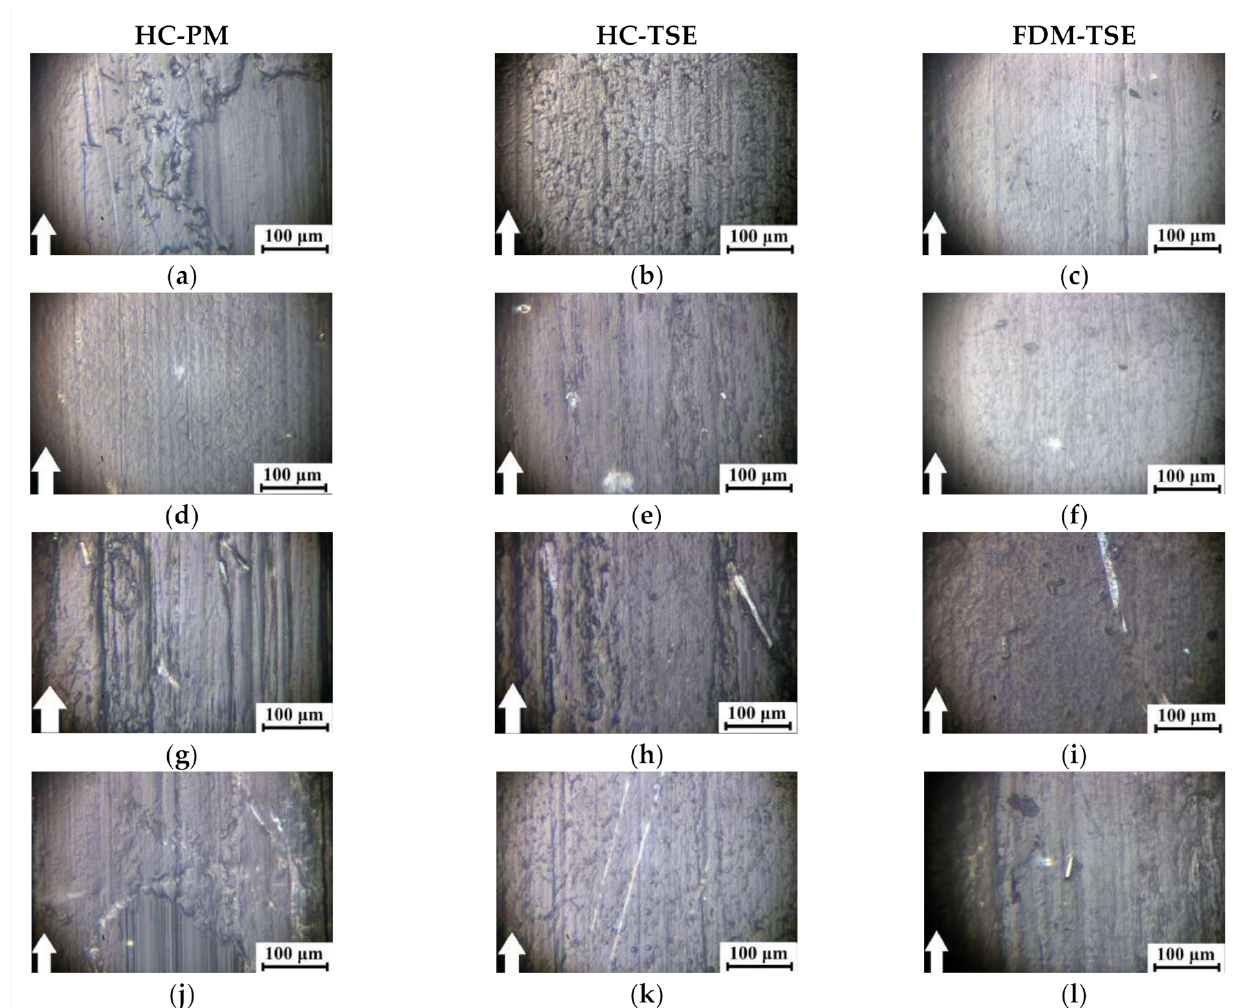
Figure 11. The wear track surfaces on the ‘UHMWPE+17%HDPE-g-VTMS+12%PP’ sample ( a – c ) and the composites ( d – l ) fabricated by the HC-PM, HC-TSE, and FDM-TSE methods: ‘UHMWPE+17%HDPE-g-VTMS+12%PP+5%HGS’ ( d – f ); ‘UHMWPE+17%HDPE-g-VTMS+12%PP+5%MGF’ ( g – i ); ‘UHMWPE+17%HDPE-g-VTMS+12%PP+5%CGF’ ( j – l ). 140 N · 0.5